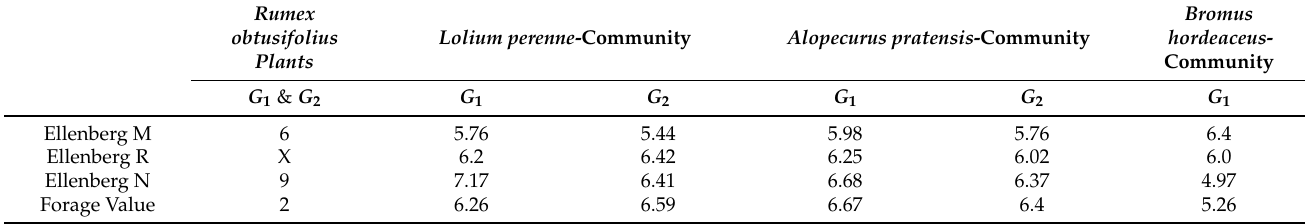
Table A2. EIV and forage values for Rumex obtusifolius plants, the Lolium perenne -, and the Alopecurus pratensis -communities in both growths and the Bromus hordeaceus -community in the first